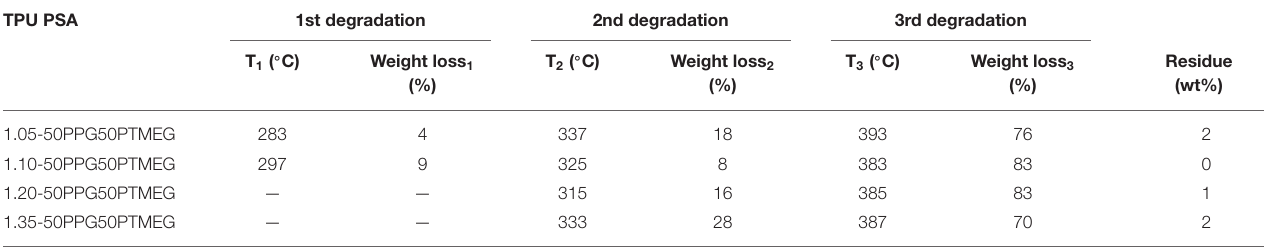
TABLE 2 | Temperatures and weight losses of the thermal decompositions of the TPUs synthesized with 50 wt% PPG + 50 wt% PTMEG blend and different NCO/OH ratios. TPU PSA 1st degradation 2nd